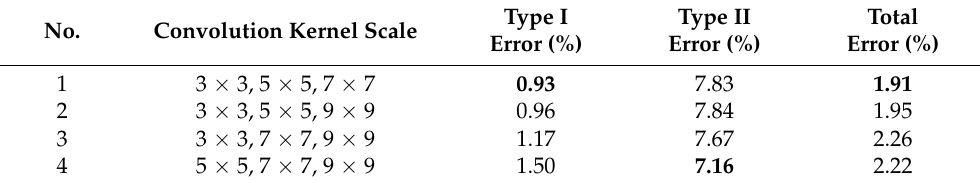
Table 7. Effects of convolution kernel combinations of different scales on filtering results. No.